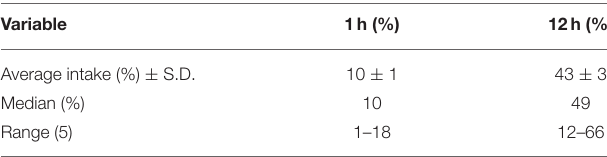
TABLE 3 | Average approximate percentage dose of flunixin consumed by lambs in the ring group ( n = 15) at 1 and 12h during the self-medication phase. Variable 1h (%) 12h (%) Average intake (%) ± S.D. 8 (24%) and 9 (23%) compared with day 7 (13%). There was